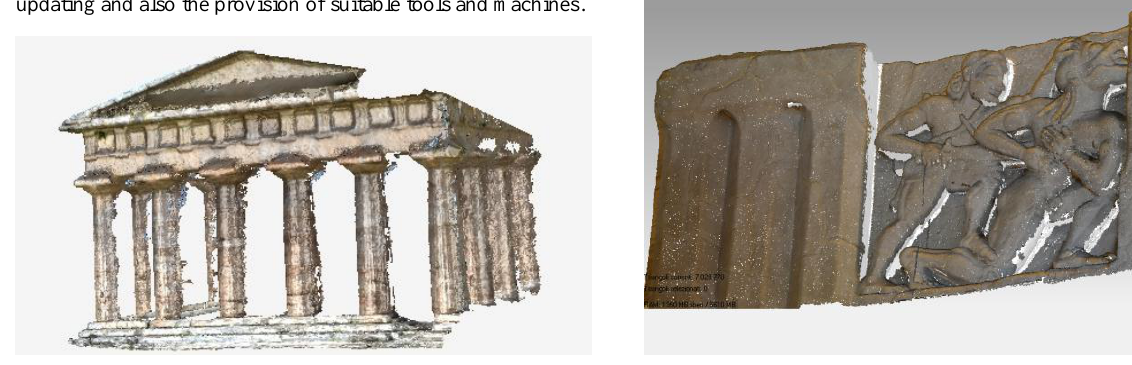
Figure 19. 3D model of the Metope